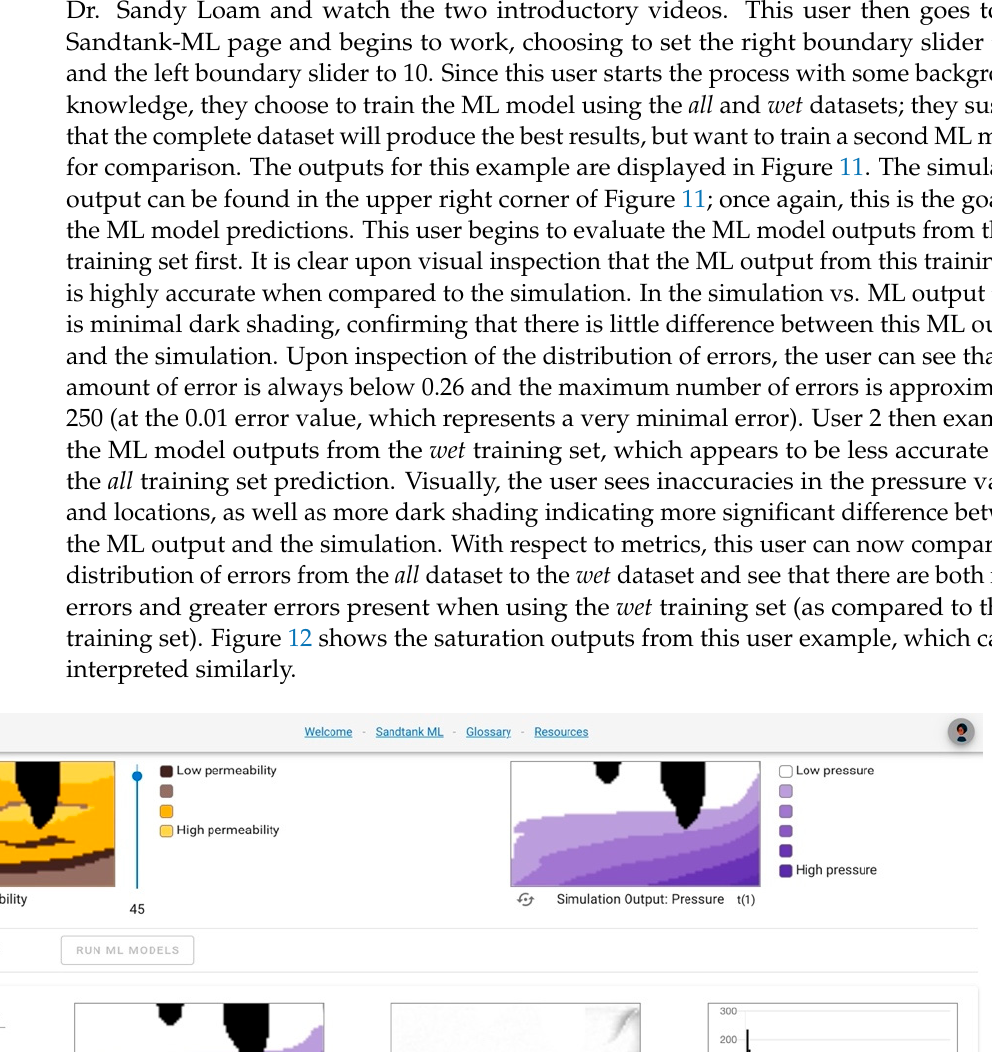
Figure 12. Sandtank-ML display for user example 2 showing the boundary condition inputs, saturation simulation output, and the associated ML saturation outputs using all and wet training datasets. 4. Discussion and Conclusions We presented an educational application at the interface of machine learning and hydrology that can be used to teach a variety of user groups about foundational ML topics as well as how ML is leveraged to complement physics-based hydrological modeling. Wa- ter managers and other users of the main HydroGEN application can use Sandtank-ML to explore various topics more in-depth then translate that understanding into confidence when using the main HydroGEN application and tackling the often described “black box“ of machine learning. Similarly, educators can use Sandtank-ML as a tool to demonstrate foundational concepts in ML for beginner students; more advanced students can apply what they already know about ML to real research scenarios. Sandtank-ML has great potential as an educational tool and we see even greater po- tential as we move from version 0.5 (current) to version 1.0. Version 1.0 will be released